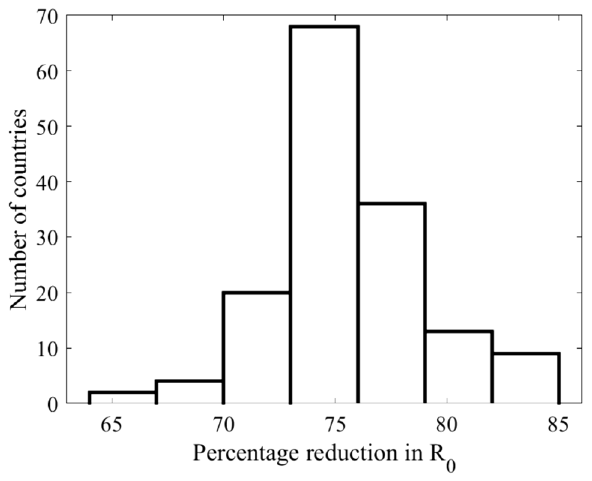
Figure 2. Histogram of percentage reduction in values of R 0 for the 152 countries 13 calculated at β = 3.5% (see Eq. (2)). The percentage reduction of the four selected countries are as follows: Canada 82%, China 76%, Mexico 74%, and Niger 73%.